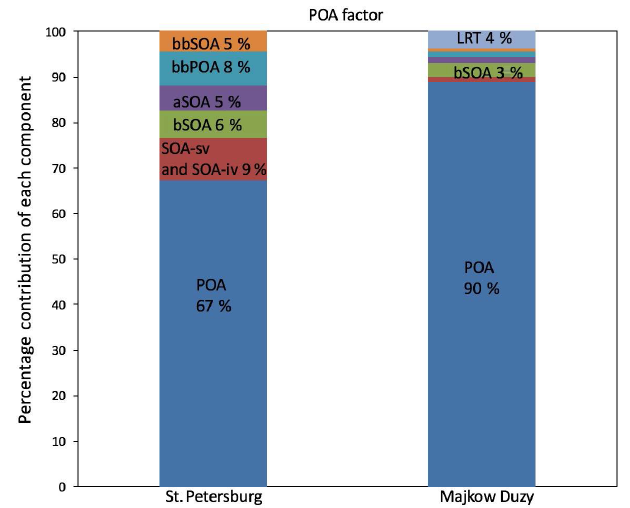
Figure 5. Contribution of each OA component to the PMCAMx- SR PMF POA factor in St. Petersburg (Russia) and Majkow Duzy (Poland) during May